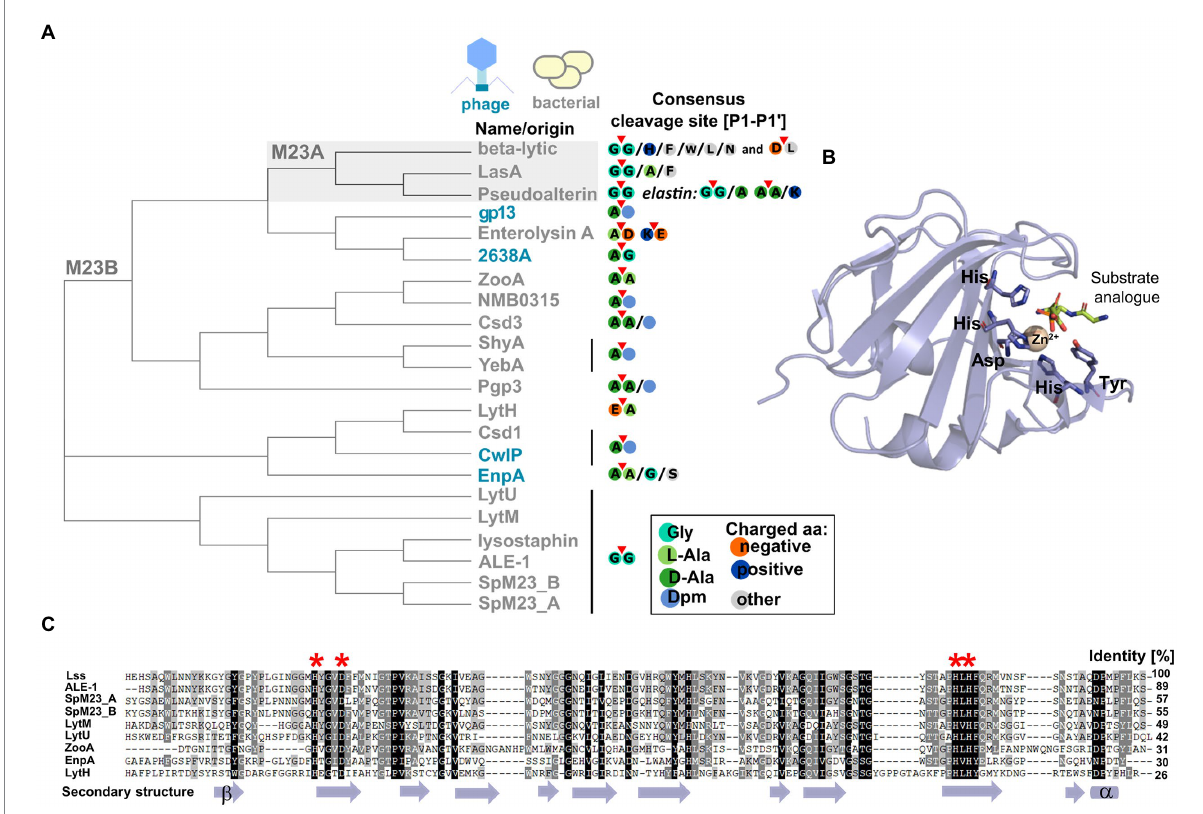
FIGURE 2 Characteristic features of M23 peptidases. (A) Phylogenetic analysis represented as a cladogram of M23 peptidases of phage (colored blue) or bacterial (colored gray) origin with their specificities. M23A subfamily was indicated against gray background. According to the nomenclature of protease substrate specificity defined by Schechter and Berger (Schechter and Berger, 1967), amino acid residues in the peptide substrate sequence are consecutively numbered outward from the cleavage sites as P4-P3-P2- P1-P1’ -P2’-P3’-P4’ and the scissile bond is located between the P1 and P1’ positions (here marked with red triangle). (B) Overall fold of M23 peptidase domain represented by LytM catalytic domain (PDB ID: 4ZYB). The structure was solved in the presence of the transition state analogue and zinc ion coordinated by conserved motifs: Hx 3 D and HxH. (C) Multiple sequence alignment performed by ClustalX and presented as Gendoc of M23B representative proteins with highly conserved zinc- binding motifs (depicted in red asterisk on the top of alignment) and secondary structure elements (depicted in violet at the bottom) assigned